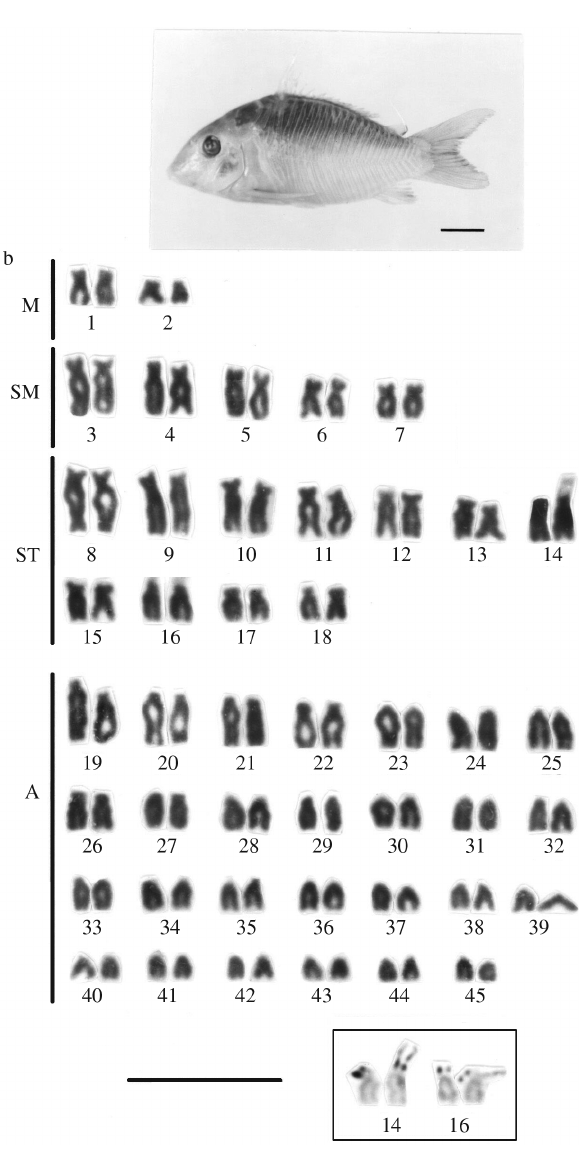
Figure 2 (cont.) - Karyotypes, Ag-NORs and specimens of b) C. britskii , 2n = 90. Scale bars: 10 µ m (karyotype) and 10 mm (specimen).